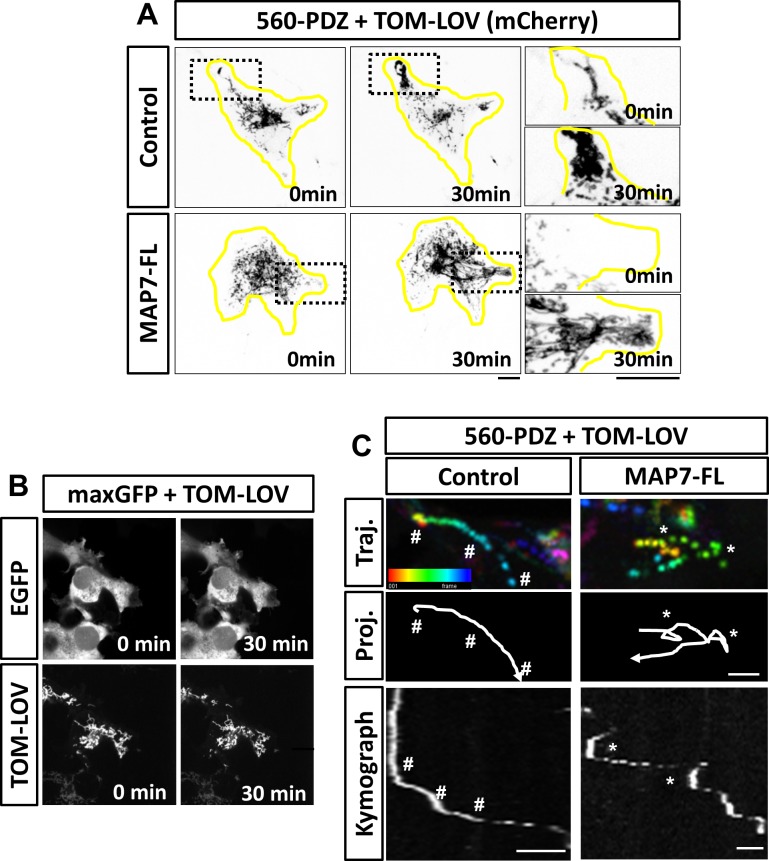
Optogenetic activation of kinesin-1-mediated mitochondrial movement in COS cells.(A) Inverted images of TOM-LOV signal in COS cells co-transfected with 560-PDZ and TOM-LOV along with the iRFP control or MAP7-FL-iRFP. Images are acquired prior to (0 min) and after light stimulation (30 min). High magnification images of boxed regions of TOM-LOV signal are shown on the right. (B) Confocal images of GFP and TOM-LOV in COS cells co-expressing pMaxGFP (as control for 560-PDZ) and TOM-LOV prior to (0 min) and after light stimulation (30 min). (C) Examples of track switch behavior in COS cells expressing 560-PDZ and TOM-LOV along with the iRFP control or MAP7-FL-iRFP. Projected images with temporal color coding of TOM-LOV mitochondria are shown in the top panel (Traj.) and the corresponding line drawings of their trajectories are shown in the middle panel (Proj.). Arrowheads indicate the direction of movement. Kymographs of the movement are shown in the bottom panel. Asterisks (*) indicate pauses followed by sharp turns, and hashes (#) indicate pauses followed by smooth runs. Scale bars: 10 µm (A-B) and 2 µm (C).